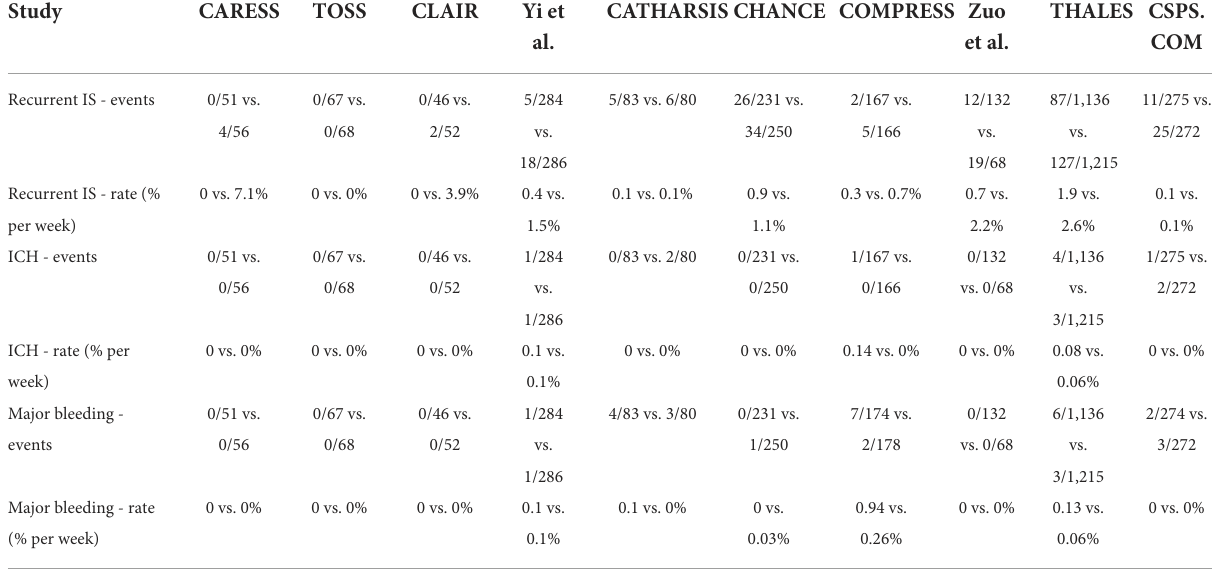
TABLE 2 Outcomes of included